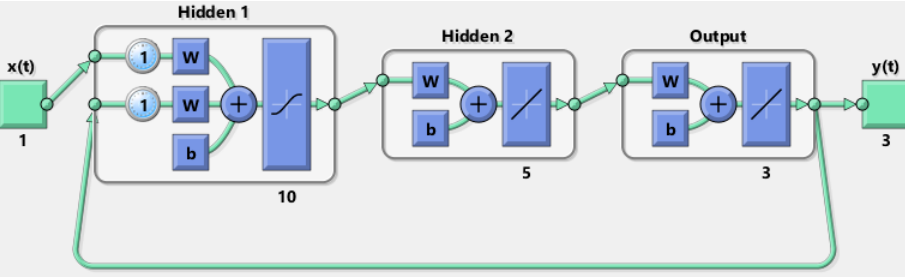
Figure 2. Structure of NARX networks identified both in the absence and presence of measurement noise.